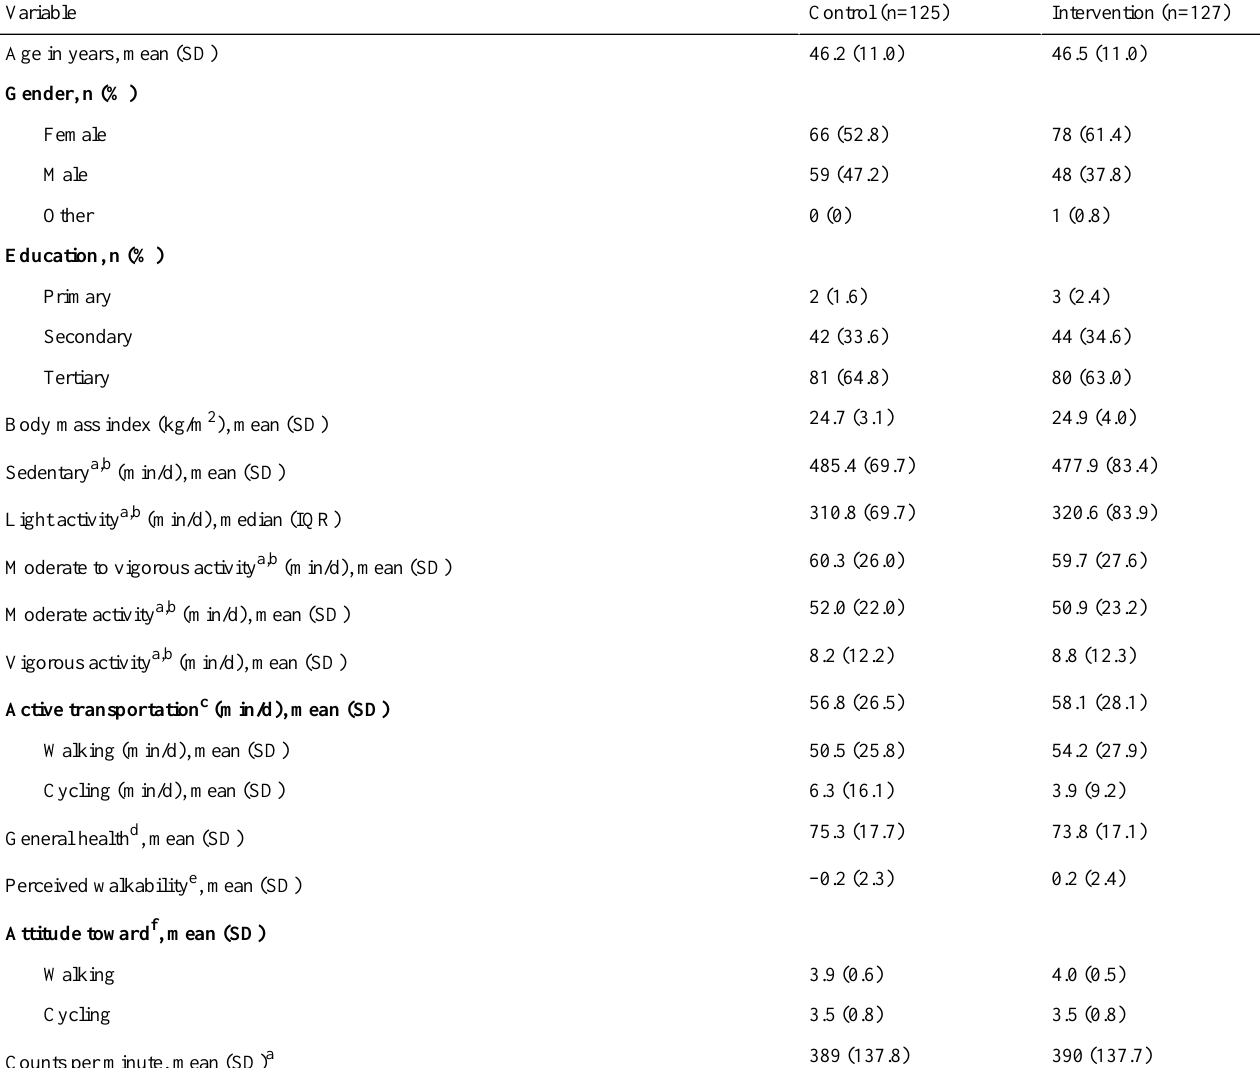
Table 1. Baseline characteristics of the participants in the Smart City Active Mobile Phone Intervention trial.